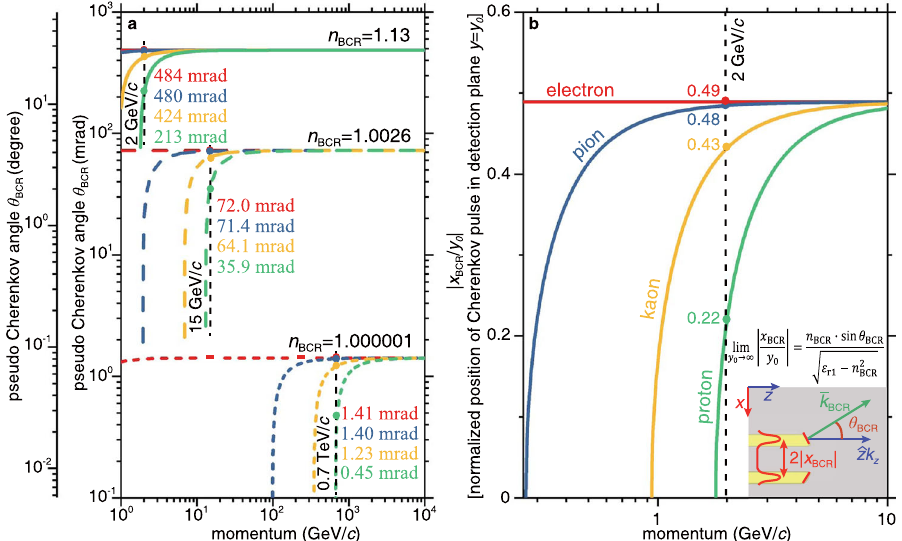
Fig. 4 Performance of Brewster-Cherenkov detectors in the identi fi cation of high-energy particles. a Pseudo Brewster-Cherenkov angle θ BCR versus particle momentum. This fi gure is plotted according to the generalized Frank – Tamm formula cos θ momentum. The values of pseudo Brewster-Cherenkov angles for four elementary particles, namely electron (red), pion (blue), kaon (yellow), and proton (green), with a momentum of 2, 15, or 700 GeV/ c are given in the plot. b Normalized peak-intensity position | x BCR / y 0 | of the transmitted Cherenkov radiation in the detection plane versus particle momentum. The measurement of | x BCR / y 0 | provides the information of θ BCR and further the particle velocity. In (b), y 0 = 2.3 mm and n BCR =